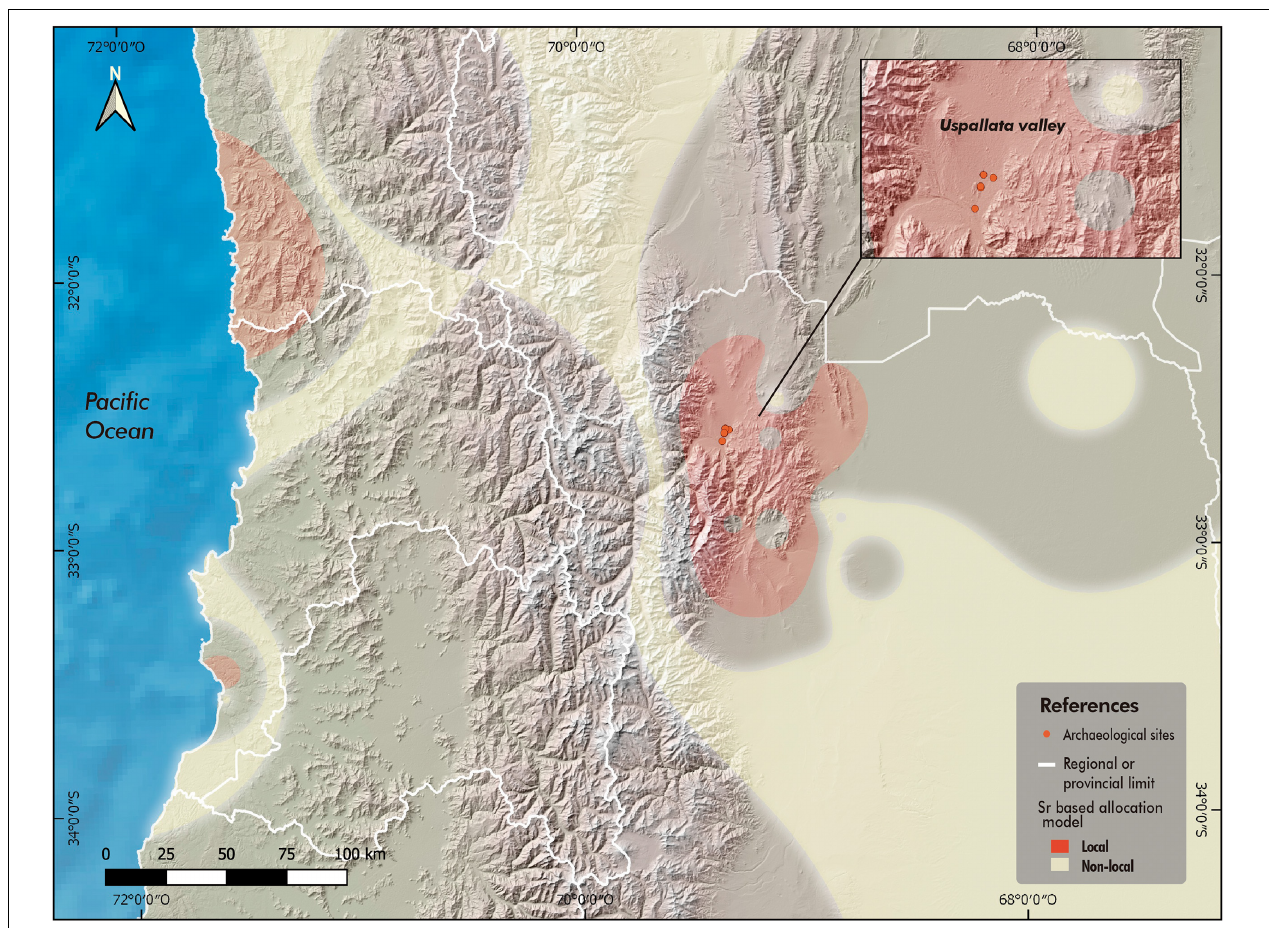
FIGURE 9 | Geographical allocation of local and non-local individuals from the Uspallata Valley (Mendoza Province,